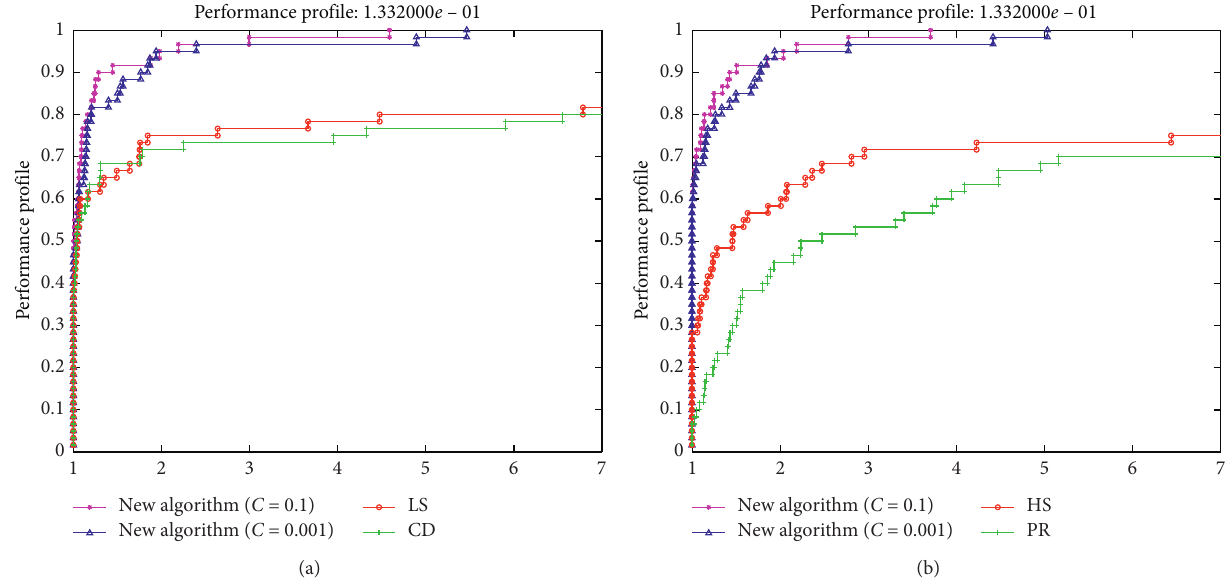
Figure 1: Performance profiles based on number of iterations (NOI). (a) Comparison of the new algorithm vs. LS and CD. (b) Comparison of the new algorithm vs. HS and PR.